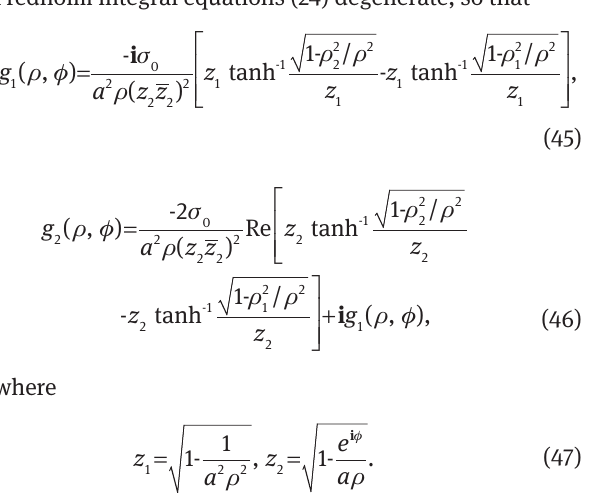
Figure 4A–C which correspond, respectively, to = 0.1, 0.2, 0.4 show the variation of the normalized r / r 1 2 stress intensity factor associated with the inner crack edge, (1) , with an angle θ plays four curves which are pertinent to e / r Similar sets of plots are provided for the outer crack edge in Figure 5A–C. It is observed that for all cases the stress